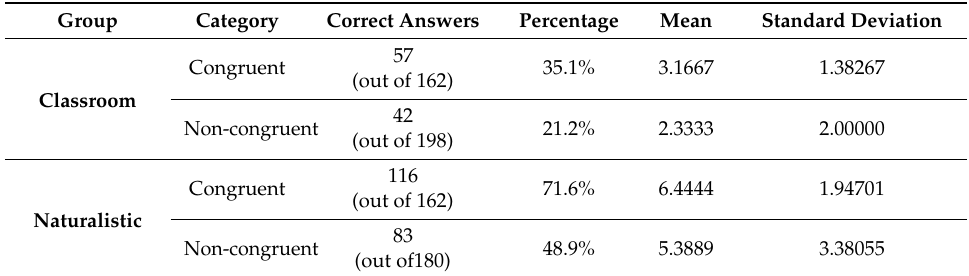
Table 4. Mean Scores of Participants’ Correct Answers on Congruent and Non-Congruent Collocations for the Two Groups.